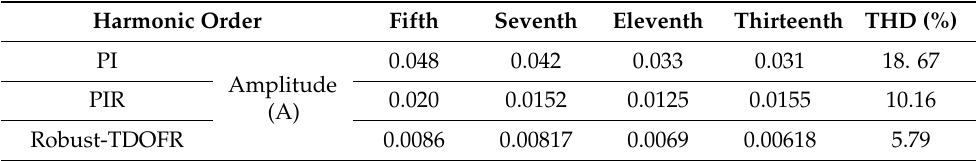
Figure 19. Experimental results of q -axis current during the load operation: ( a ) with a PI controller, ( b ) with a PIR controller and ( c ) with a Robust-TDOFR controller.